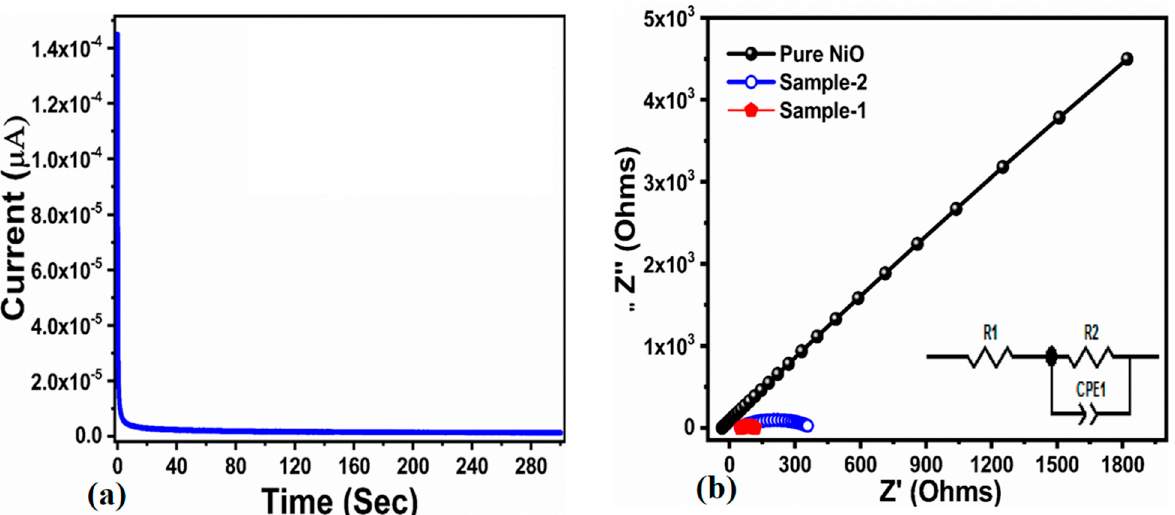
Figure 6. ( a ) Stability measurement using chronoamperometry at 0.5 V for 300 s in the presence of 0.1 mM urea, ( b ) fi tt ed Nyquist plots for pure NiO and sample 1 and sample 2 measured at 100 kHz to 0.1 Hz, sinusoidal potential of 10 mV and biasing potential of 0.5 V in 0.1 mM urea.